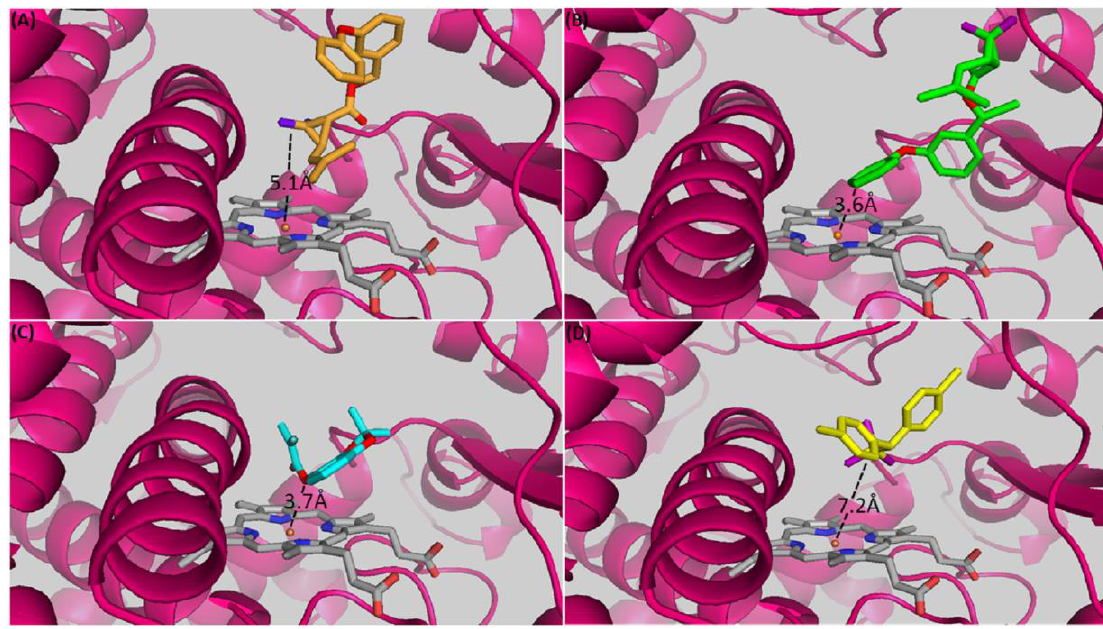
Figure 6. Predicted binding mode of ( A ) permethrin (bright orange stick), ( B ) deltamethrin (green stick), ( C ) bendiocarb (cyan stick), and ( D ) 1,1,1-trichloro-2,2-bis( p -chlorophenyl)ethane (DDT) (yellow stick) in A. funestus CYP6AA1. CYP6AA1 helices are presented in hot pink; heme atoms are in stick format and grey. Distance between possible sites of metabolism on the insecticides and heme iron are annotated in